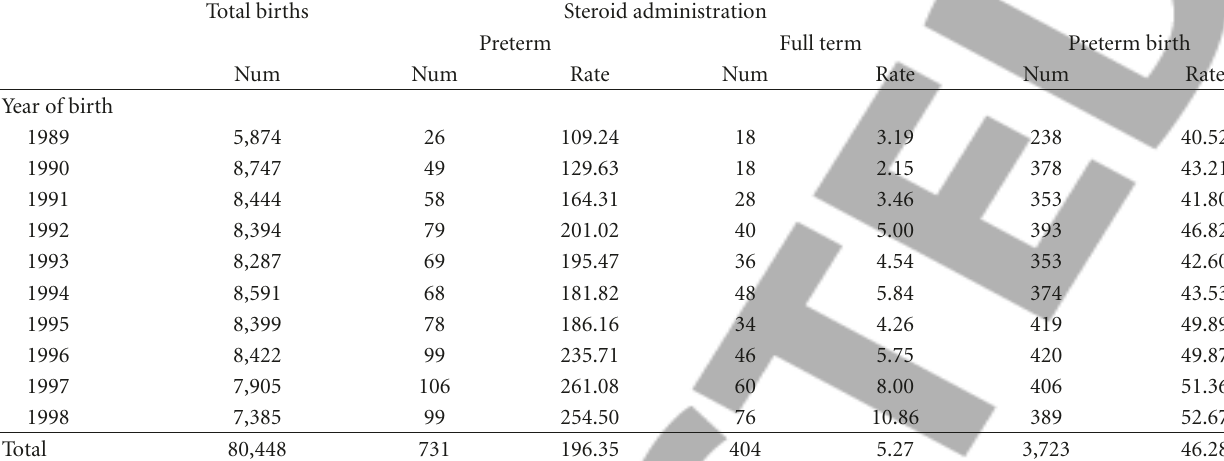
Table 2: Rates of antenatal steroid therapy administration and preterm birth by year of birth. Total births Steroid administration Preterm Full term Preterm birth